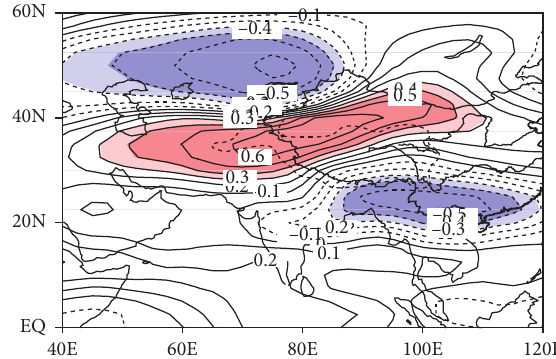
W (solid curve) and I r